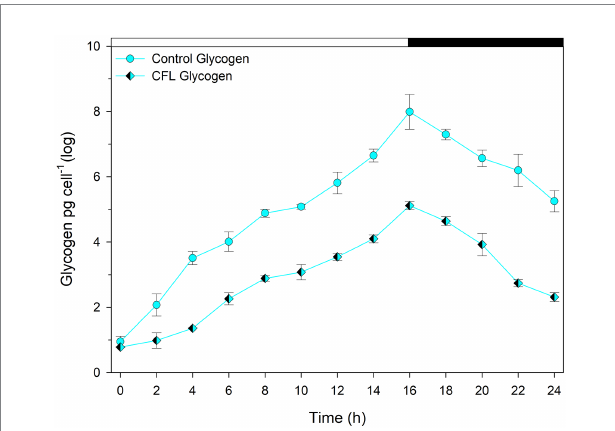
FIGURE 4 Concentration of total glycogen in synchronous Galdieria sulphuraria cultures. Control culture (cyan diamonds), CFL–treated culture (cyan- black diamonds). The dark phase is indicated by the black bar above the graph. The data are plotted as means of biological triplicates. The error bars represent standard deviations (±SD) and are shown when larger than the symbol size. For details of statistical analysis (multiple linear regression) see Supplementary Table